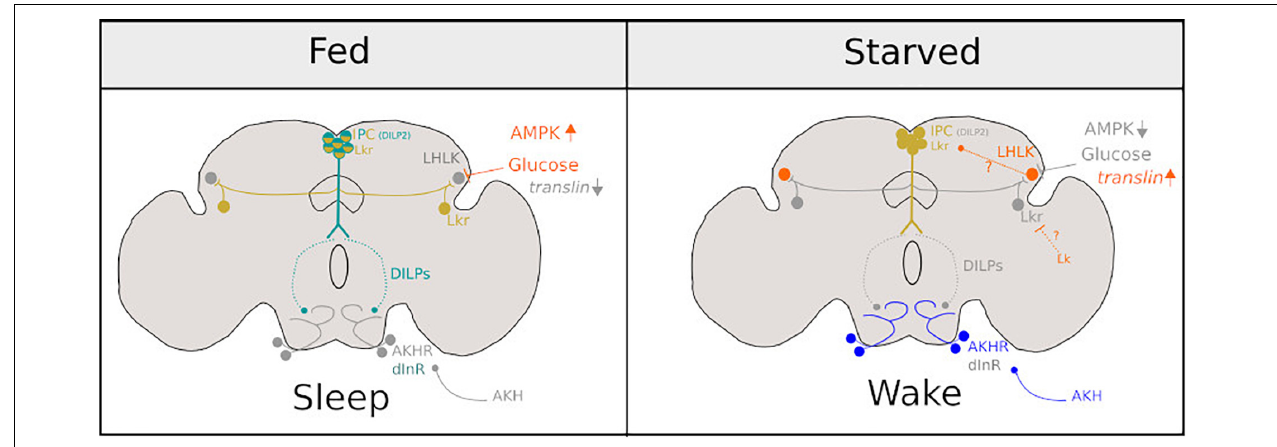
FIGURE 2 | Diagram representing the neurons involved in promoting sleep under fed conditions (Left) and sleep suppression under starved conditions (Right) . Bright colours represent neuronal activity and grey represents neuronal inactivity under fed and starved conditions in Drosophila. Figure is adapted from Melnattur and Shaw